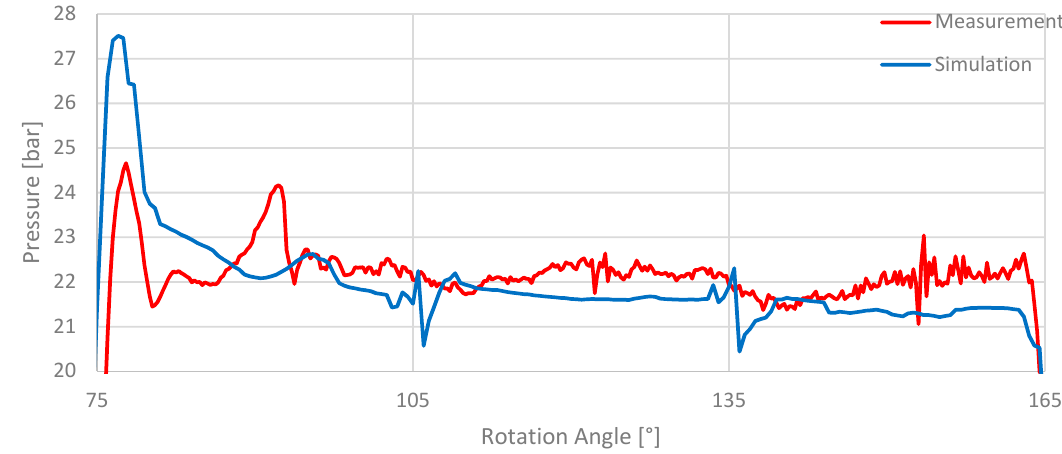
Figure 10. Detailed view of the displacement chamber pressure monitored during the delivery port pass by. The operating point is 2000 rpm and 20 bar delivery pressure.